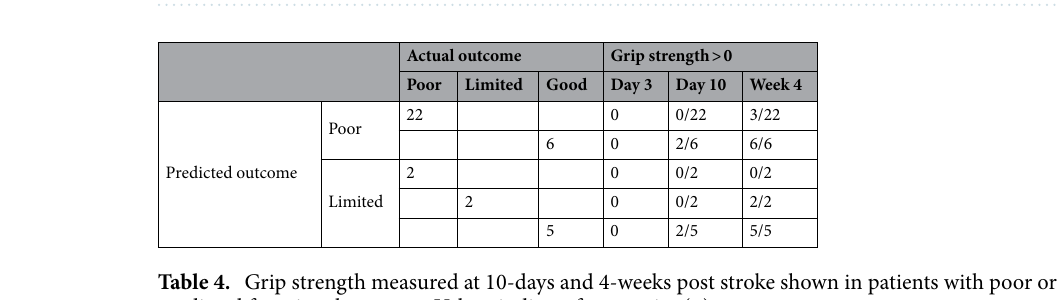
Figure 3. Conditional probability tree algorithm along with 95% confidence intervals for the 5 functional outcome strata according to Action Research Arm Test assessed at 3-months after stroke.